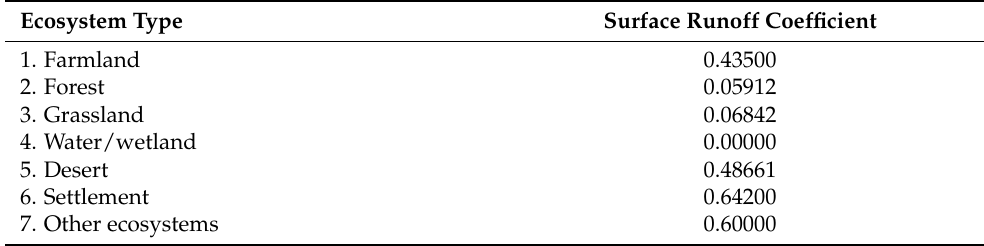
Table 1. Surface runoff coefficient for each ecosystem [ 2 , 34 , 35 ] .